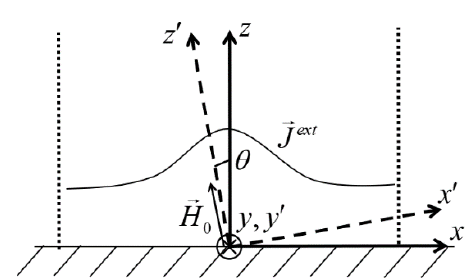
Figure 1. LEAIM system with an external current source. Imaginary side walls are shown by dashed lines. The z , z’ -axes belonging to the coordinate frames shown in the figure are aligned vertically upwards and along the direction of the geomagnetic field, respectively.